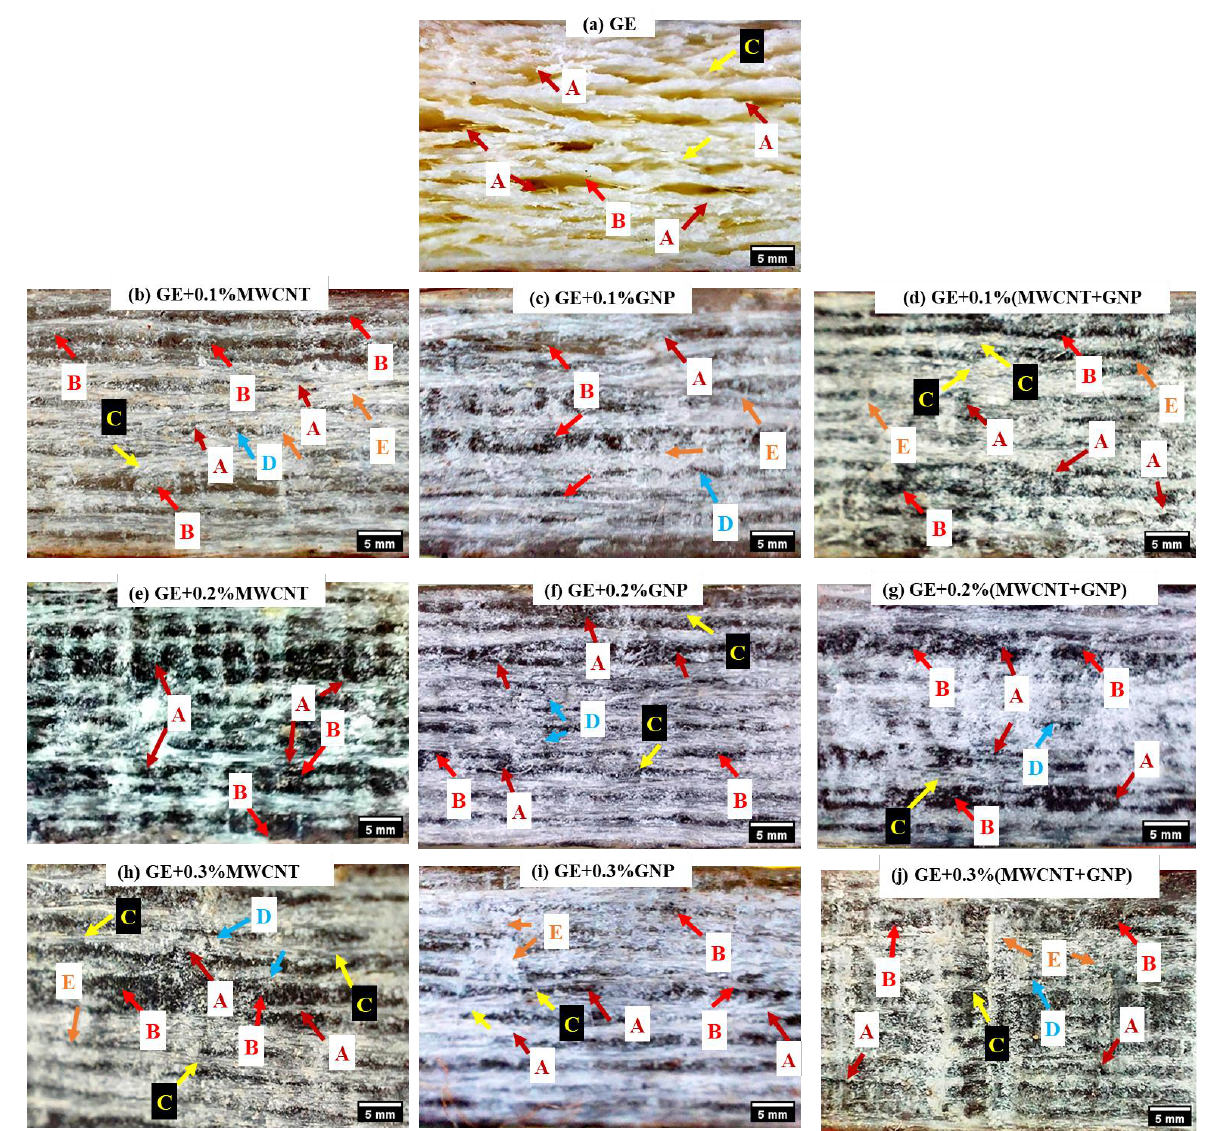
Figure 16. ILSS failure of GE and its nanocomposites (UD).